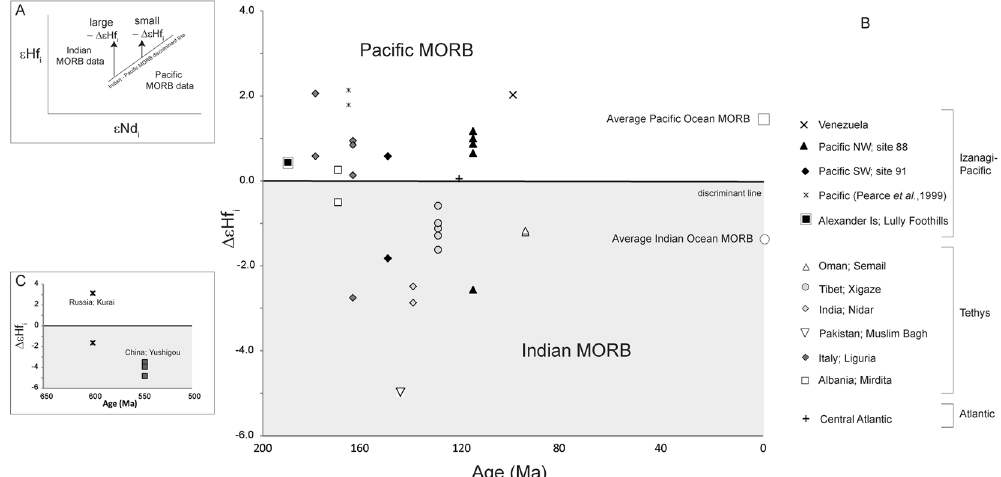
Figure 2. Age of ophiolite basalts (symbols in key) versus Δε Hf i (explanation of notation in top inset). (Lu-Hf decay constant = 1.867 × 10 − 11 55 , CHUR values of 176 Lu/ 177 Hf = 0.0336 and 176 Hf/ 177 Hf = 0.282785 56 . Indian– Pacific MORB discriminant line and calculation parameters from Pearce et al . 29 ; Δε Hf i = 1.6 ε Nd i – ε Hf i . [Note: Pearce et al. 29 , referred to parameter as Δε Hf P/I ]. Negative Δε Hf i values indicate sample affinity with Indian Ocean MORB chemistry. Such compositions are evident in the signatures of Tethyan basalts, even in 550 Ma MORB basalts from early Paleo-Tethys (bottom inset; China: Yushigou and Russia: Kurai). See Supplementary Information Part 2 for sample details. Average values for present-day Indian and Pacific MORB calculated from PetDB database and references